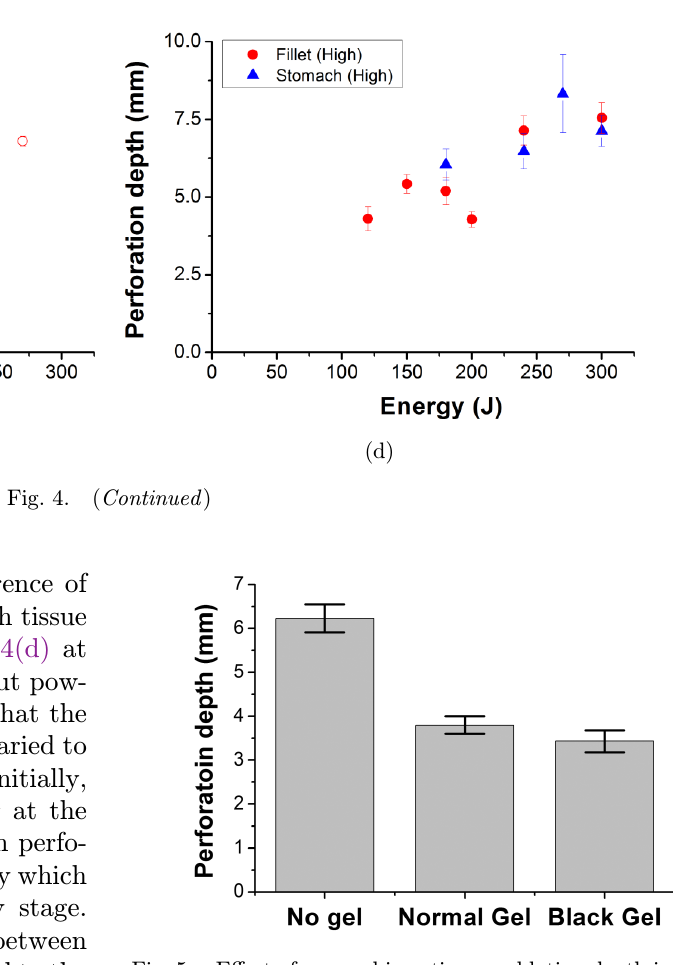
Fig. 5. E®ect of agar gel insertion on ablation depth in multi- layered porcine tissue-agar gel